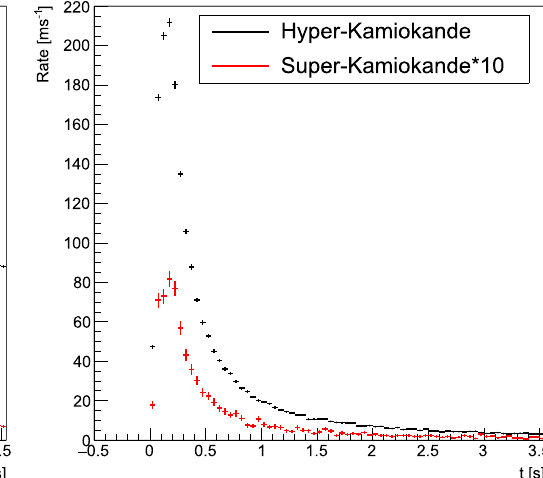
Fig. 2 Simulated neutrino light-curves with 50ms binning, showing the event rates for IceCube (black) and ARCA (red) on the left and Hyper-Kamiokande (black) and Super-Kamiokande, zoomed vertically